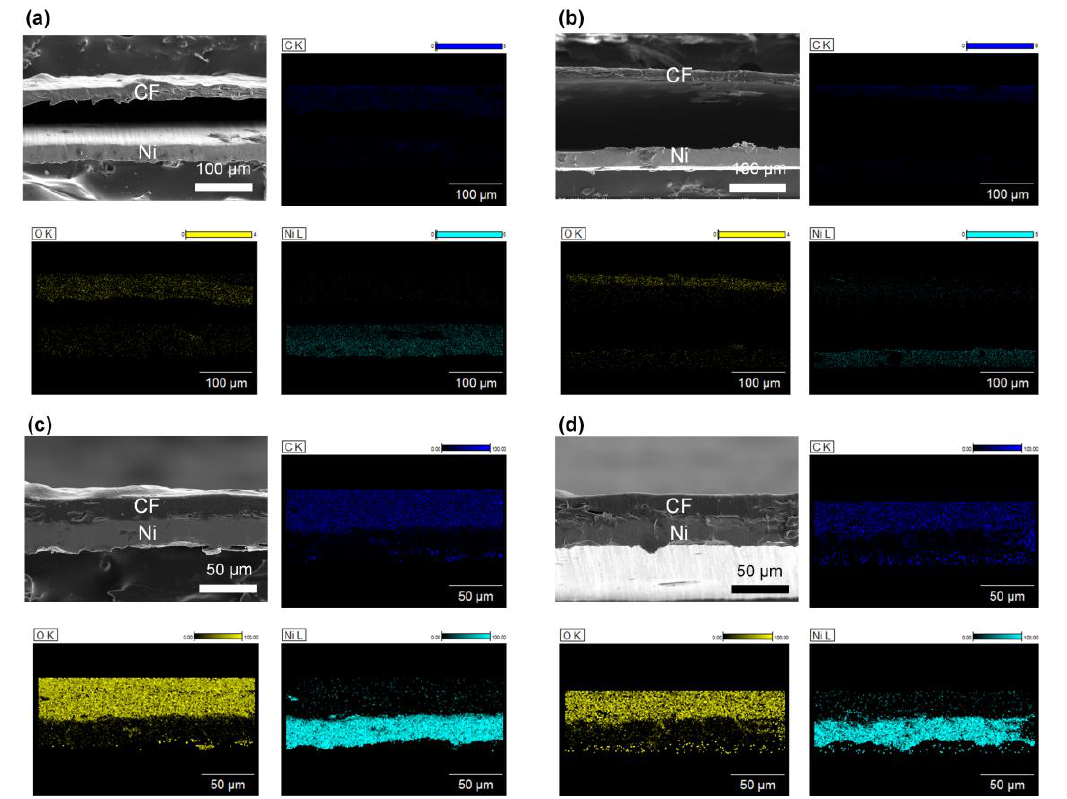
Figure 6. FE − SEM images of the cross-view morphology with EDS profiling of ( a ) CN200, ( b ) CN500, ( c ) CN300, and ( d ) CN400. EDS profiles are according to each FE − SEM image. The PE and MS phases were identified by detecting the distribution of carbon, oxygen, and nickel atoms.